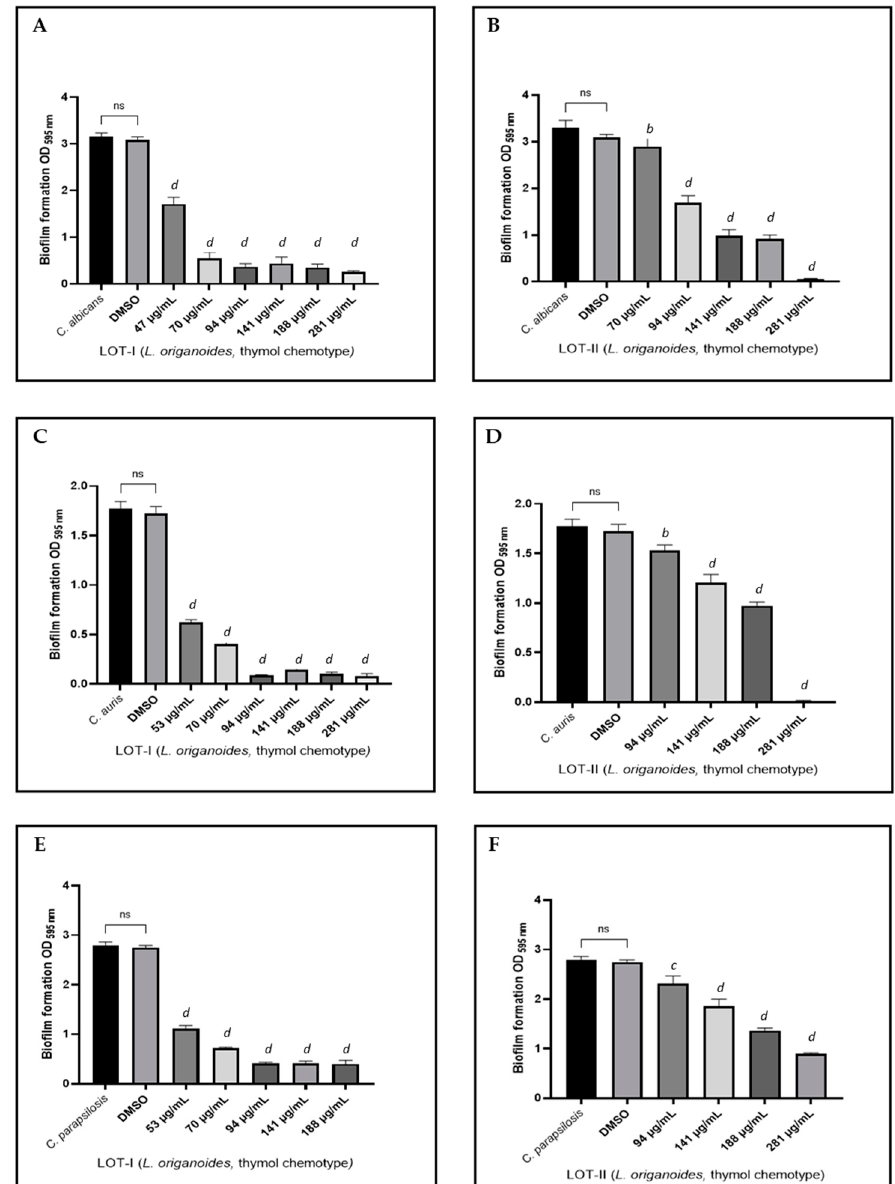
Figure 2. Effect of antifungal EO LOT-I ( L. origanoides , thymol chemotype) and LOT-II ( L. origanoides , thymol chemotype) on biofilm formation of C. albicans ATCC 10231 ( A , B ), C. auris CDC B11903 ( C , D ), and C. parapsilosis ATCC 22019 ( E , F ). Letters denote a significant difference between the treated and untreated controls, based on Tukey’s test (ns: p > 0.05 b : p ≤ 0.01; c : p ≤ 0.001; d : p ≤ 0.0001).